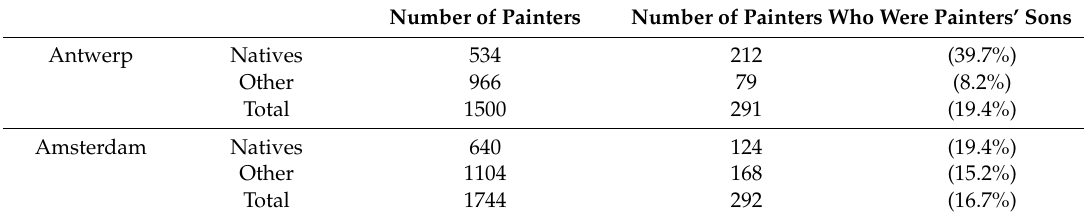
Table 3. Painters that were painters’ sons, Amsterdam and Antwerp, 1600–1700. Number of Painters Number of Painters Who Were Painters’ Sons